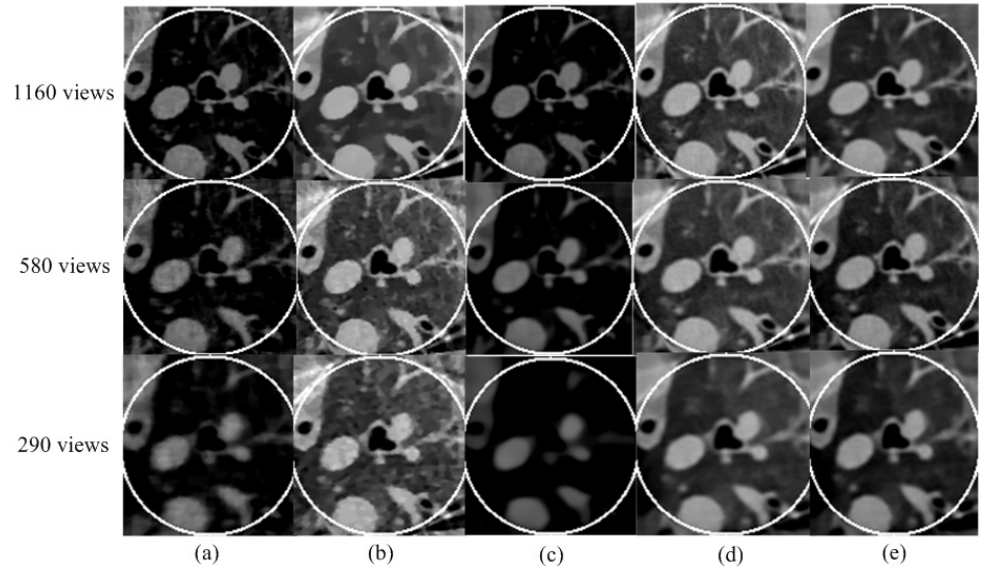
Figure 8. Reconstructed ROIs from low-dose real sheep projection data using five different methods: ( a ) SIRTV + BOS; ( b ) SIRTV + OS; ( c ) SIRDL + BOS; ( d ) SIRDL + OS; ( e ) SIRDL + HL. The display window is [ − 700 800]HU.